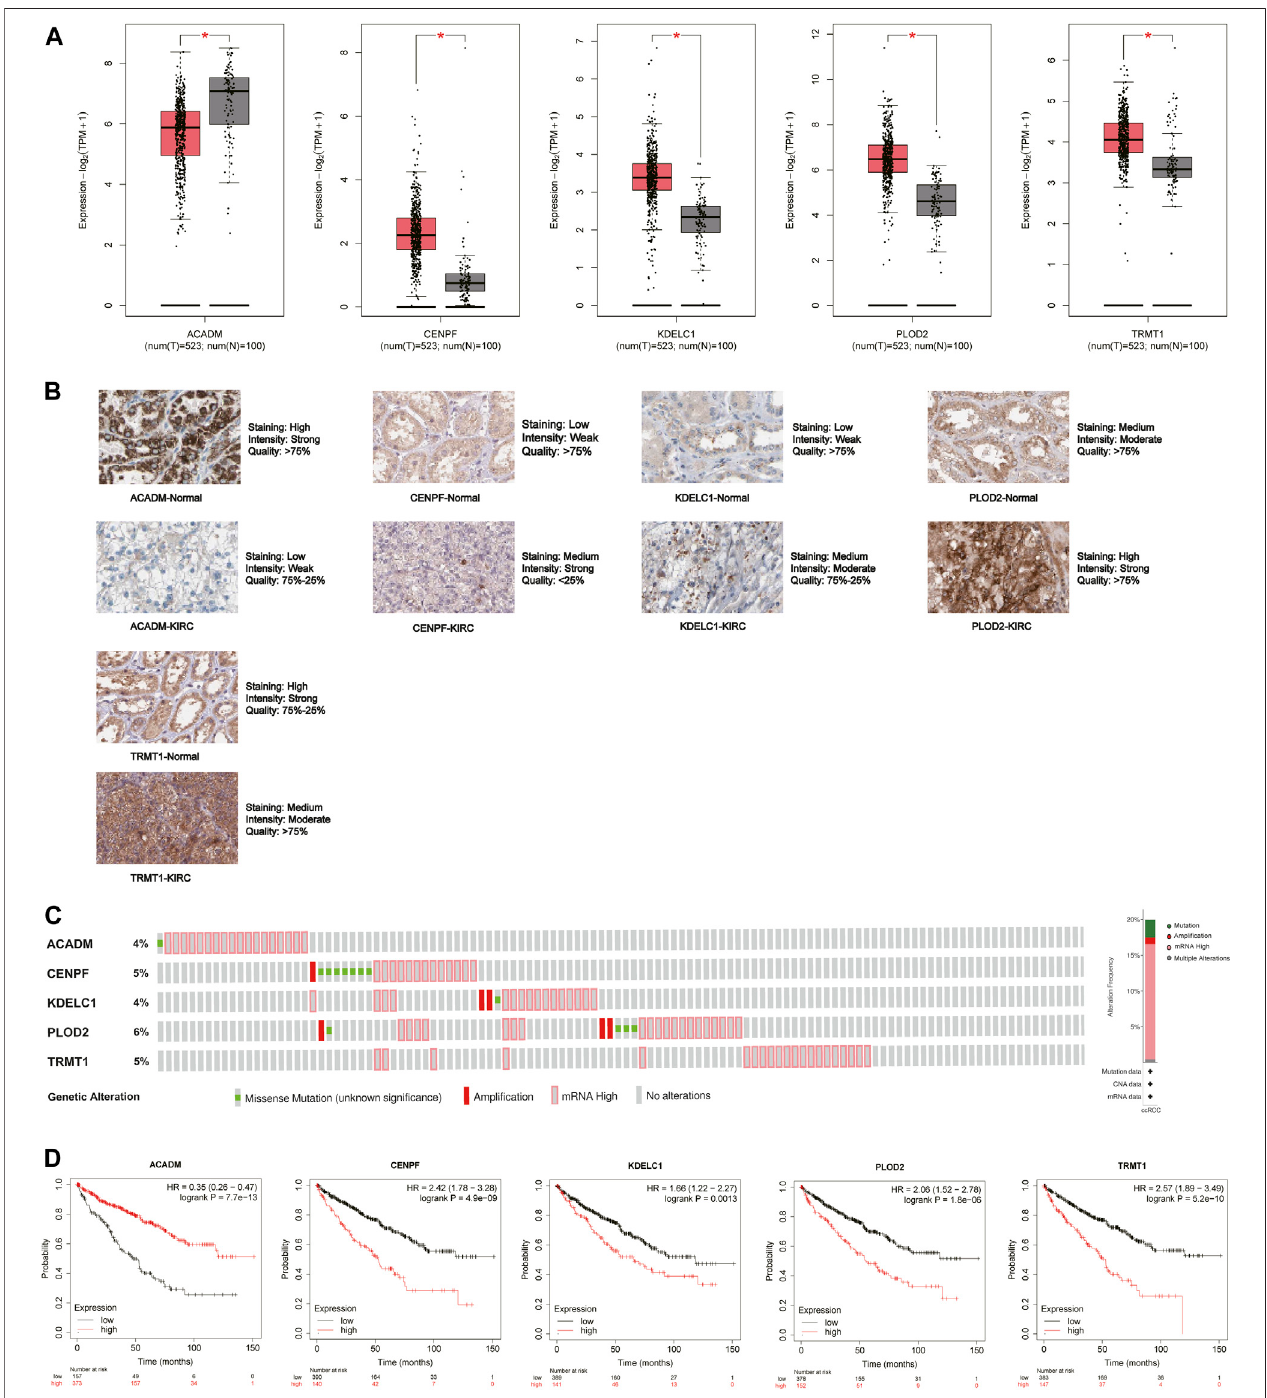
FIGURE 6 | Expression and prognostic value of the fi ve model genes ( ACADM , CENPF , KDELC1 , PLOD2 , and TRMT1 ) in KIRC. (A) mRNA expression level between KIRC tissues and normal renal tissues in GEPIA; the cutoff of |log2FC| was set to 0.5, and the p -value was 0.05; (B) Protein expression level detected by immunohistochemistry in HPA; (C) Alteration frequency of the fi ve hub SARS-CoV-2 – related genes in 446 KIRC patients; (D) Prognostic value of fi ve hub SARS-CoV- 2 – related genes in KIRC by the Kaplan Meier – plotter.